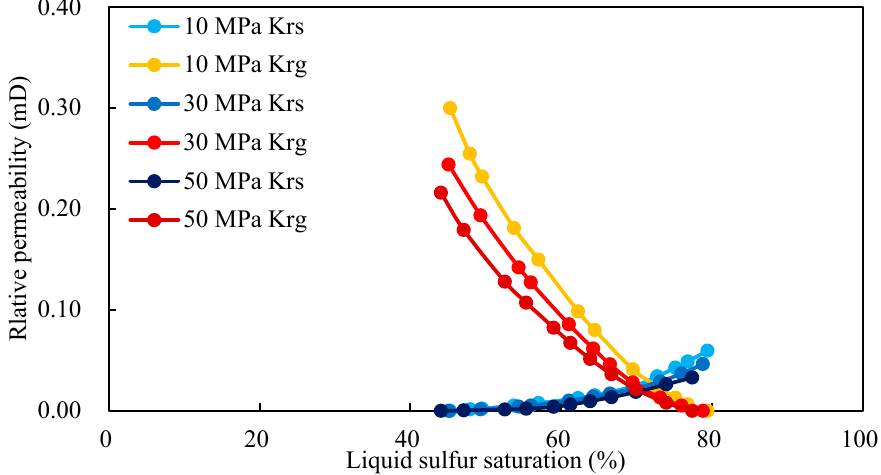
Figure 8. Gas–liquid sulfur relative permeability curves of Core 2 at different confining pressures.